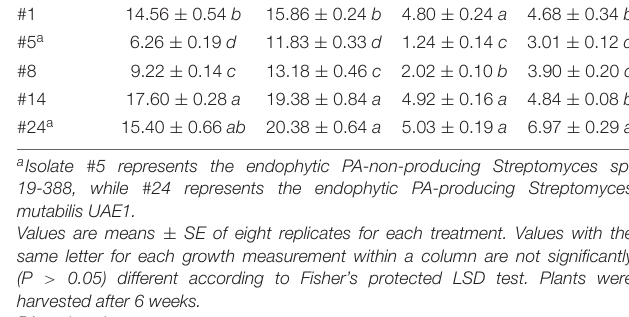
TABLE 3 | Effect of endophytic PA-producing actinobacterial isolates on growth parameters of mangrove ( Avicennia marina ) under gnotobiotic conditions. Treatment